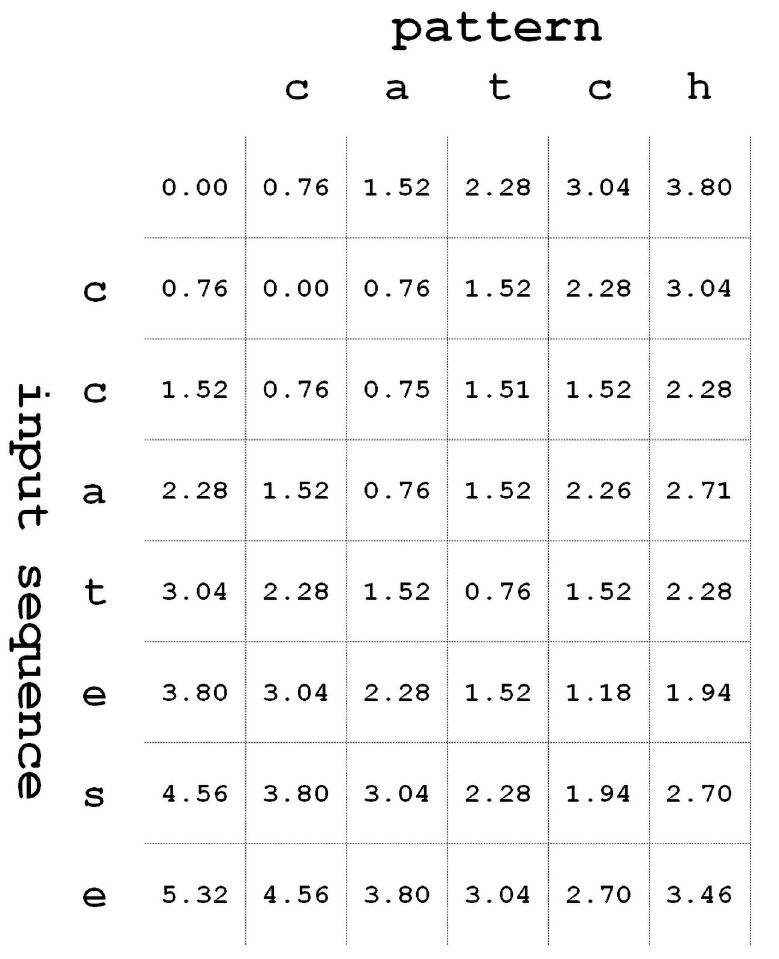
Fig 2. Example of generalized edit distance matrix for input sequence “ccatese” and pattern “catch”.